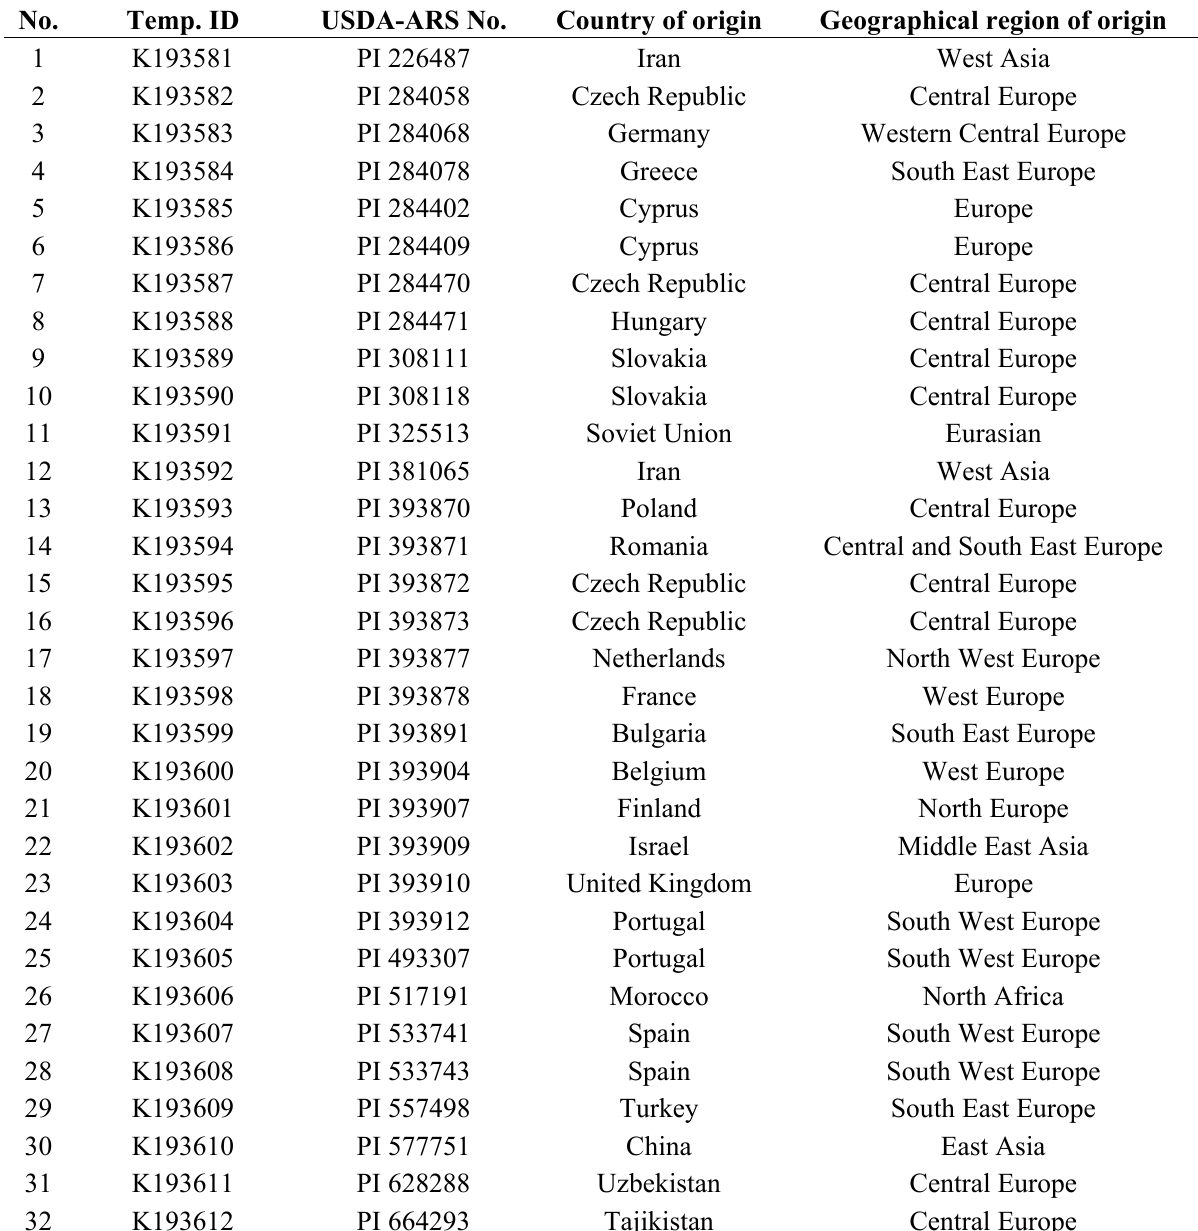
Table 3. List of common vetch ( Vicia sativa subsp. sativa )